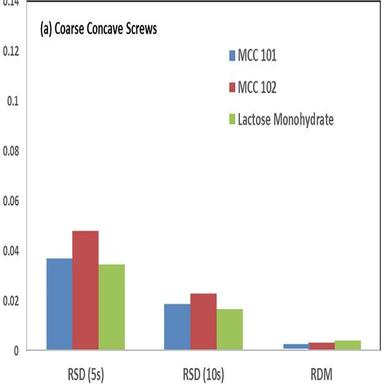
Feeding RSD (5 and 10 s moving average) and RDM of MCC PH101, MCC PH102 and Lactose Monohydrate with (a) Coarse Concave Screws, (b) Fine Concave Screws, (c) Fine Auger Screws. All runs were at 70% Drive Command. RSD: relative Standard Deviation. RDM: relative deviation from the Mean.